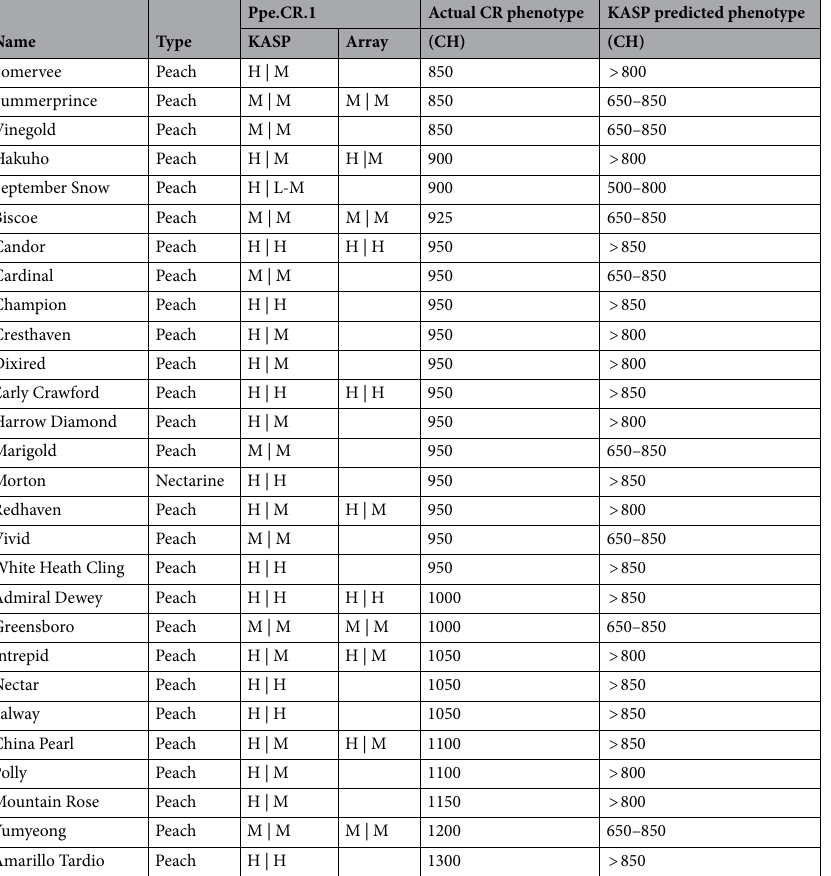
Table 1. Chilling requirement (CR) of the U.S. peach breeding germplasm and selections, and Ppe.CR.1 KASP assay prediction of CR in peach germplasm and comparison with 9K IPSC SNP array data (www. rosac eae. org, tfGDR1048/b). Bold accessions indicate disagreement between KASP and array data. Predicted CR for Ppe.CR alleles are indicated in the table: low (L), low-moderate (L-M), moderate (M), and high (H). *Chill hour (CH) data obtained from the